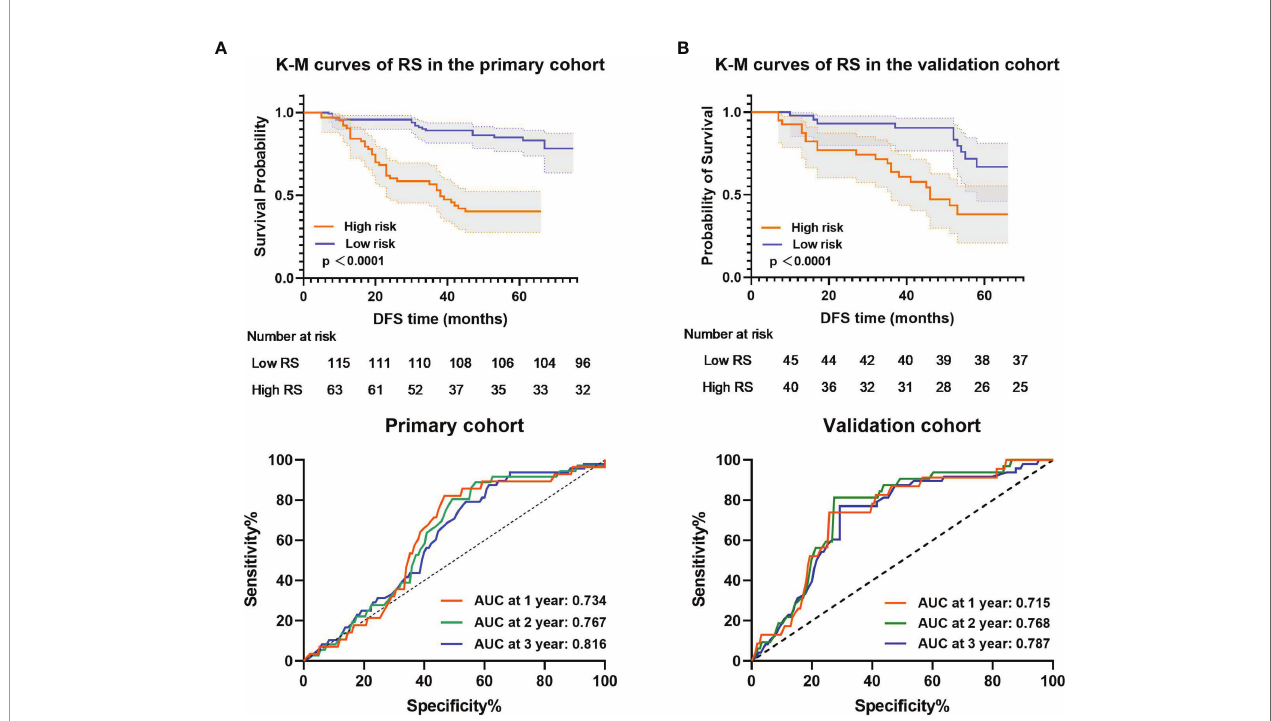
FIGURE 4 | Kaplan – Meier analysis and time-dependent ROC curves of the radiomic signature. p values were calculated using a two-sided log-rank test, and AUCs at 1, 2, and 3 years were calculated to assess the prognostic accuracy within the (A) primary cohort (n = 178) and (B) validation cohort (n = 85). Shadows represent 95% CI. DFS represents disease-free survival. CI represents con fi dence interval.